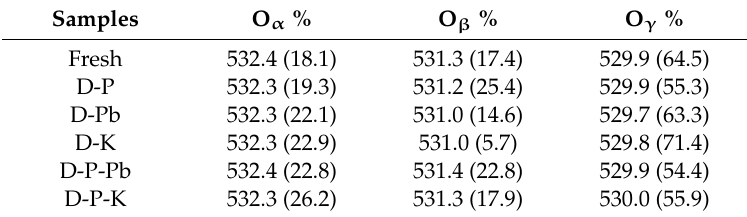
Figure 5. In situ DRIFTS spectra of the reaction between NO + O 2 and adsorbed NH 3 species over ( a ) fresh and ( b ) D-P at 350 ◦ C. Table 2. The position and atom ratio of O spices in XPS spectra for each